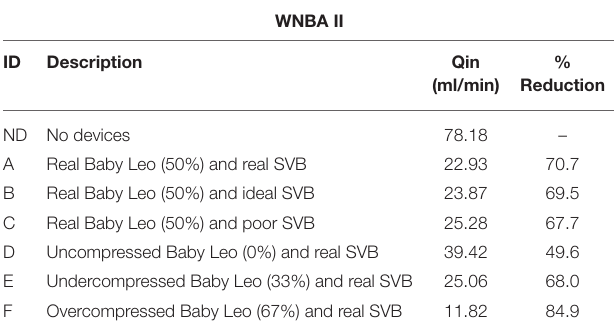
TABLE 3 | Percentage reductions of total flow entering the sac of WNBA II with different deployment strategies and different compression